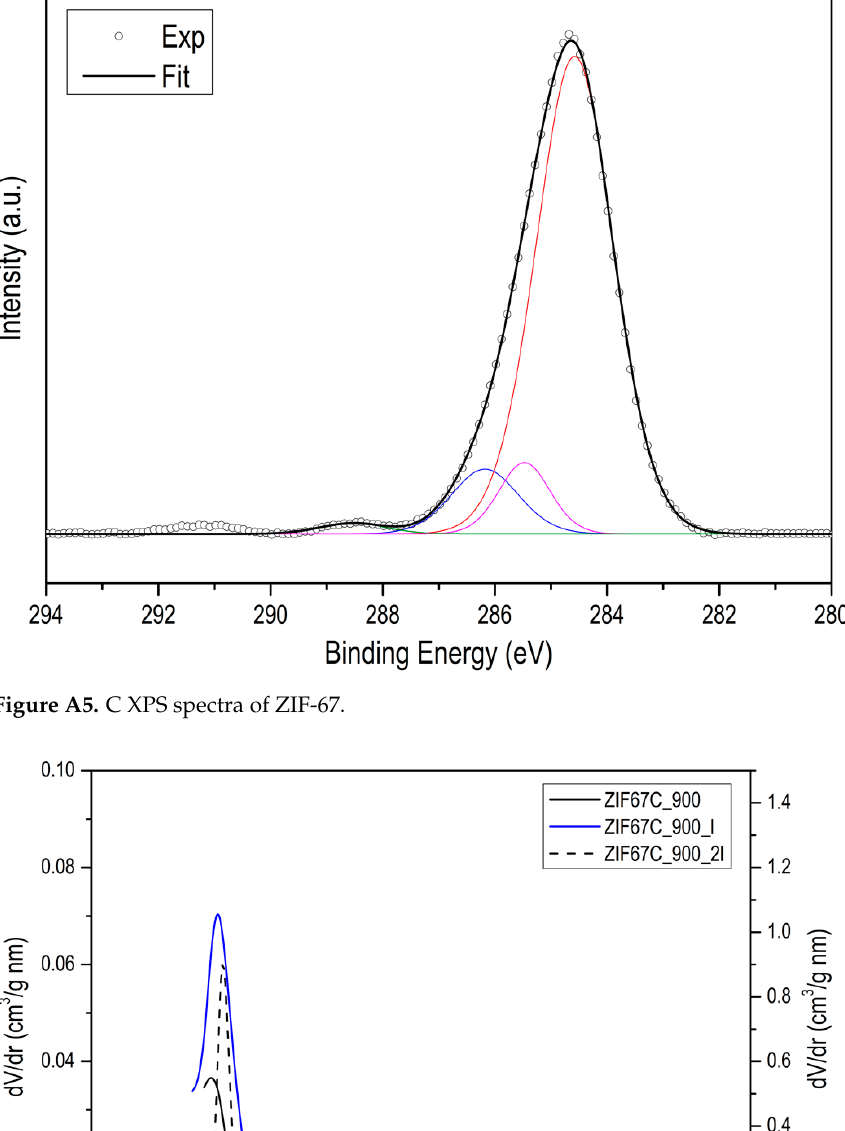
Figure A4. N XPS spectra of ZIF-67.